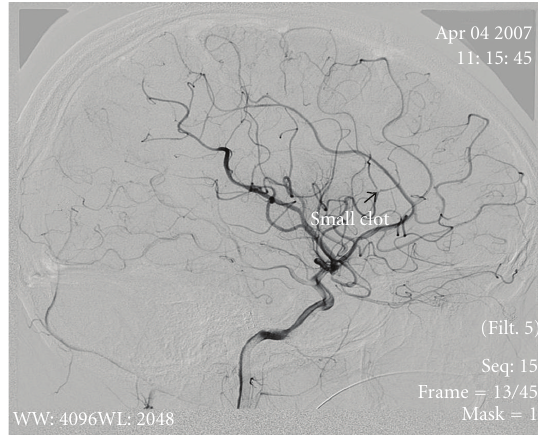
Figure 4: Sagittal view demonstrating a significant improvement in blood flow after rt-PA Abciximab and nitroglycerin were infused. Arrow points to a small residual